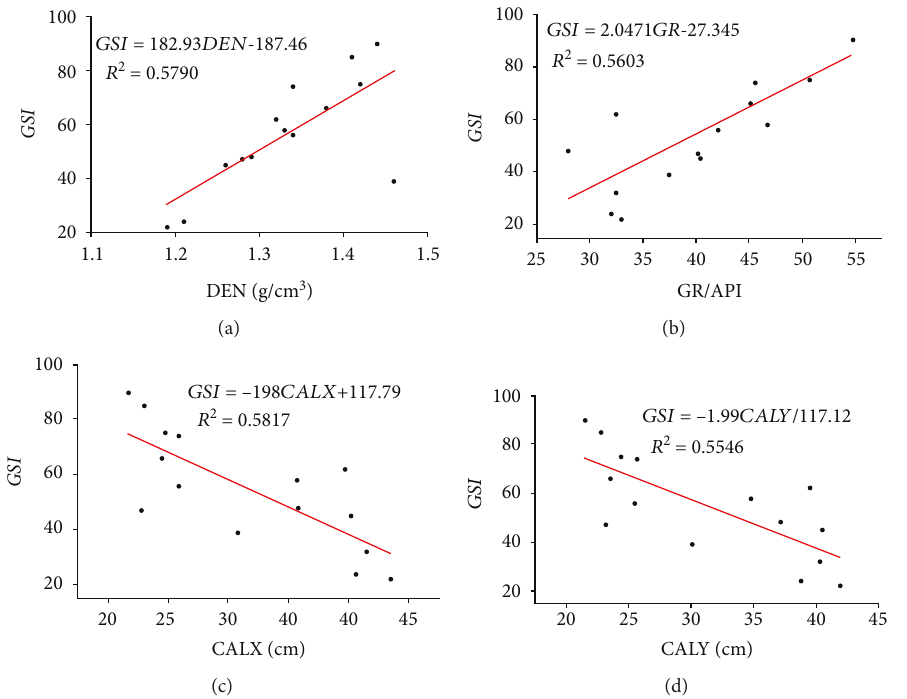
Figure 3: (a) The relationship between volume density and GSI. (b) The relationship between natural gamma ray and GSI. (c) The relationship between borehole diameter of the X direction and GSI. (d) The relationship between borehole diameter of the Y direction and